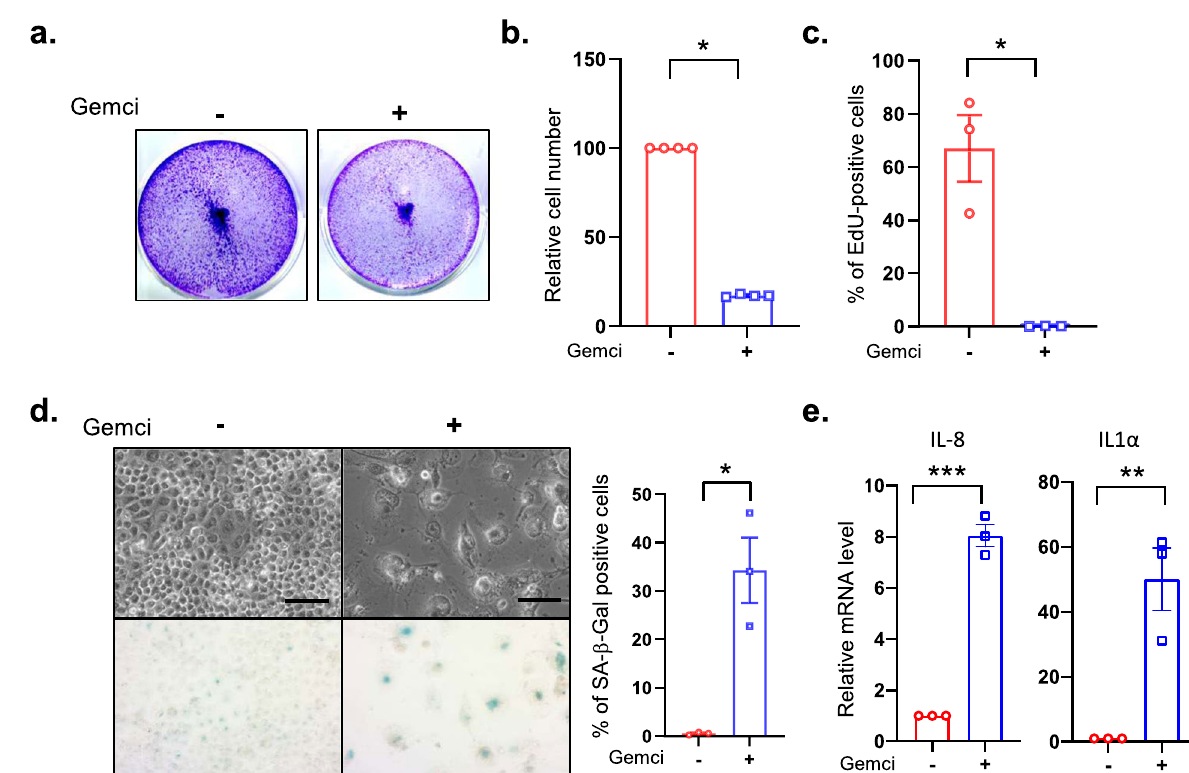
Fig. 2 Chemoresistant Panc1 cells display senescence features in response to gemcitabine treatment. Panc1 were treated with gemcitabine at 620 nM. a , Four days after treatment, cells were fixed and stained using crystal violet. b‑c , Three thousands cells were seeded in 96‑well plates and treated or not with gemcitabine. Three days later, cells were incubated with EdU for 1 h before fixation and staining of EdU‑positive cells and of the nuclei with Hoechst dye were performed. Images were automatically acquired using an Operetta imaging system before quantification of the number of cells ( b ) and of the percentage of EdU‑positive cells ( c ) ( n were fixed and SA‑β‑Gal stained. Representative images are shown and percentage of positive cells was calculated ( n Student t‑test). e , RT‑qPCR against IL‑8 and IL1α on gemcitabine treated or not treated cells were performed and normalized to TBP level ( n